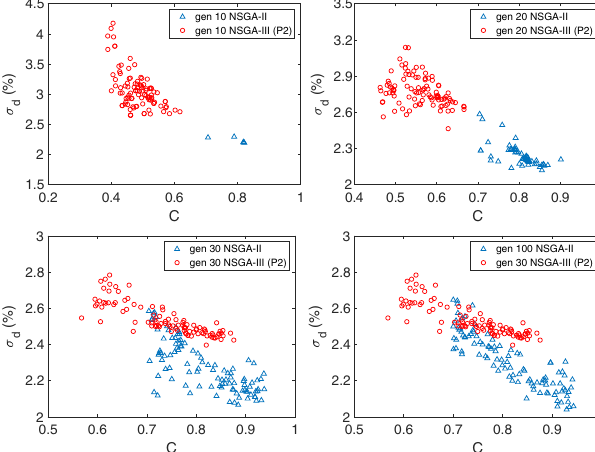
FIG. 11. Projection of the Pareto-optimal front obtained by the NSGA-II and NSGA-III (P) with a population size of 100 in different generations.